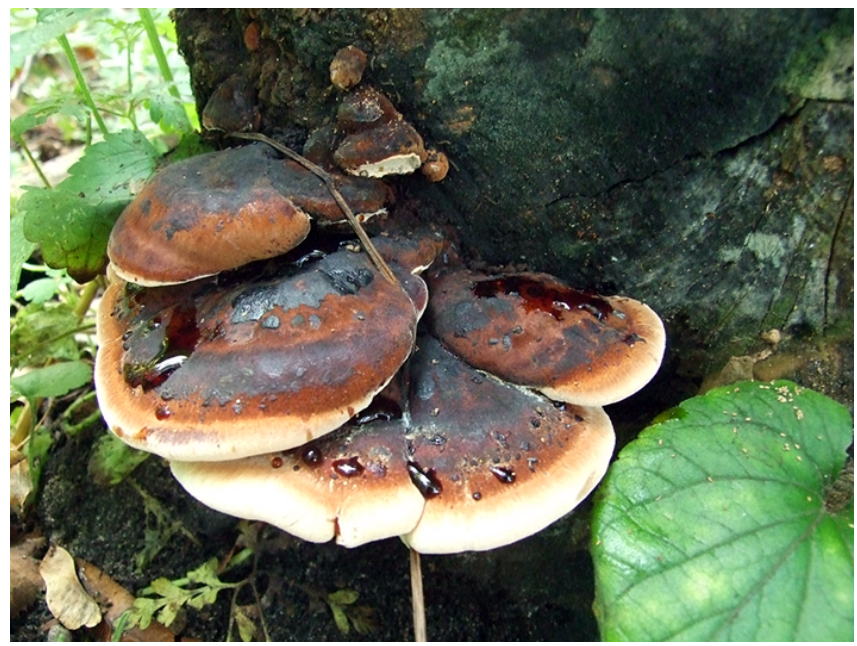
Figure 4 Ischnoderma resinosum . Photo by B.